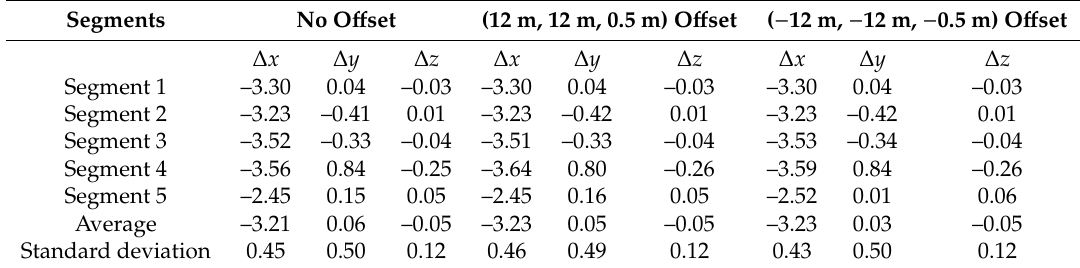
Table 5. Geolocation errors relative to the ICESat-2 data with multiple datasets (unit: